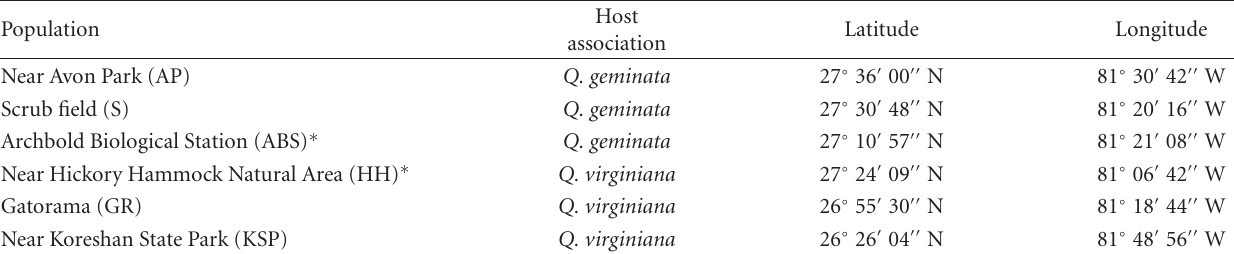
Table 1: Locations and host plant associations of the six B. treatae populations from central Florida used in the present study.